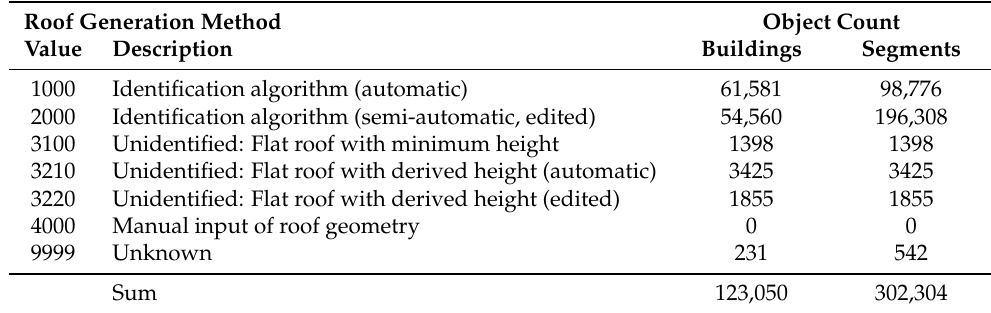
Table 3. Distribution of the large-scale dataset by roof generation method of the 3D city data: numbers of buildings and single roof segments for each method. Classification according to